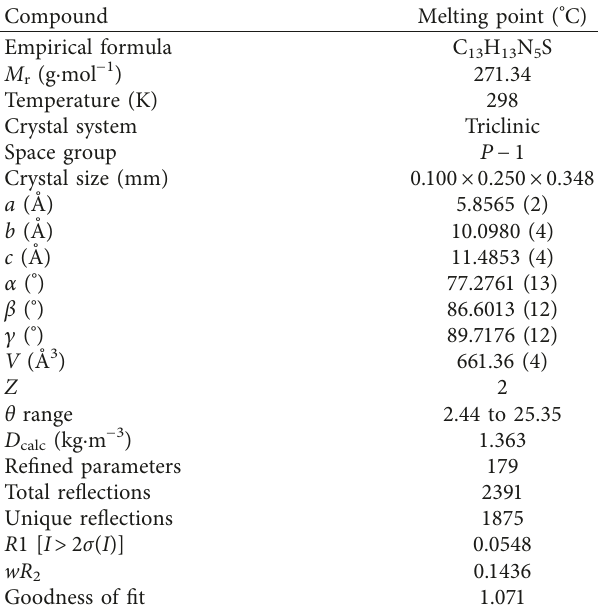
Table 1: Summarized crystallographic